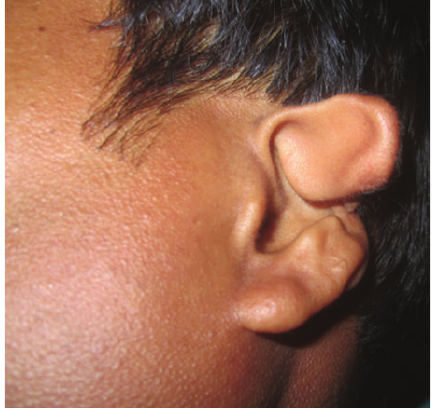
Figure 3: Left ear cleft.